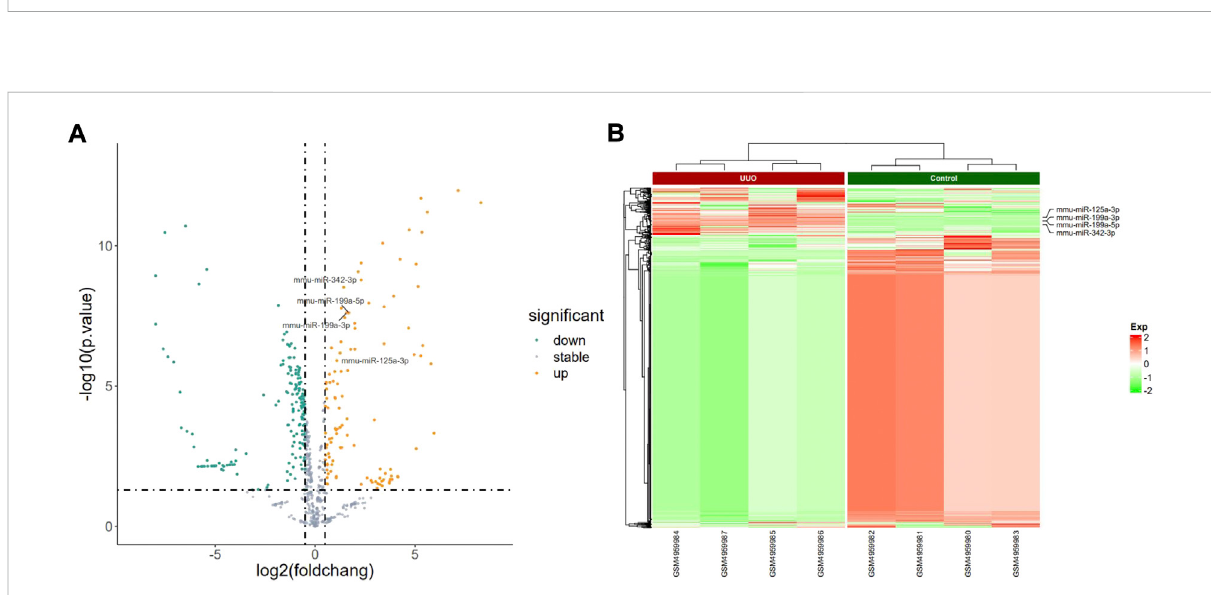
FIGURE 3 Pro fi ling of DEmiRNAs in the UUO group and control group in GSE162794. (A) Volcano plots. Orange represents upregulation and green represents downregulation. (B) Heatmaps. Red represents upregulation and green represents